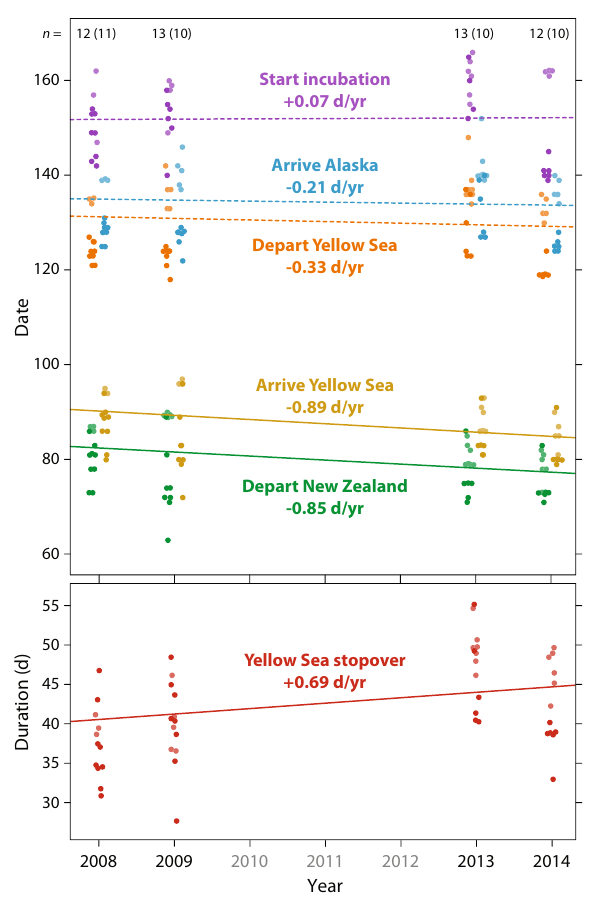
Fig. 4 Northward migration and breeding phenology for geolocator- tracked godwits in 2008, 2009, 2013, and 2014. Points for overlapping stages and individuals are offset for clarity. Within each stage (distinguished by color), dark and pale dots indicate individuals breeding in southern (<64°N) and northern (>64°N) Alaska, respectively (Fig. 2a). Lines indicate signi fi cant (solid) and non-signi fi cant (dashed) slopes during 2008 – 2014, derived from linear mixed models (see Supplementary Table 3). Numbers across the top of the plot indicate the number of tracked birds per year (smaller sample of incubating birds in parenthesis). Date: 1 =